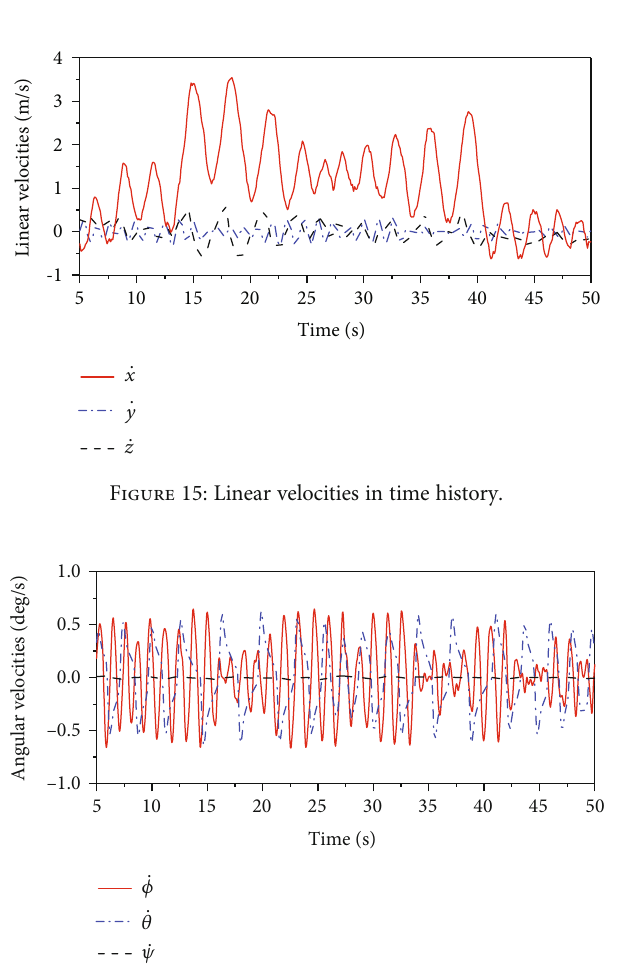
Figure 16: Angular velocities in time history.